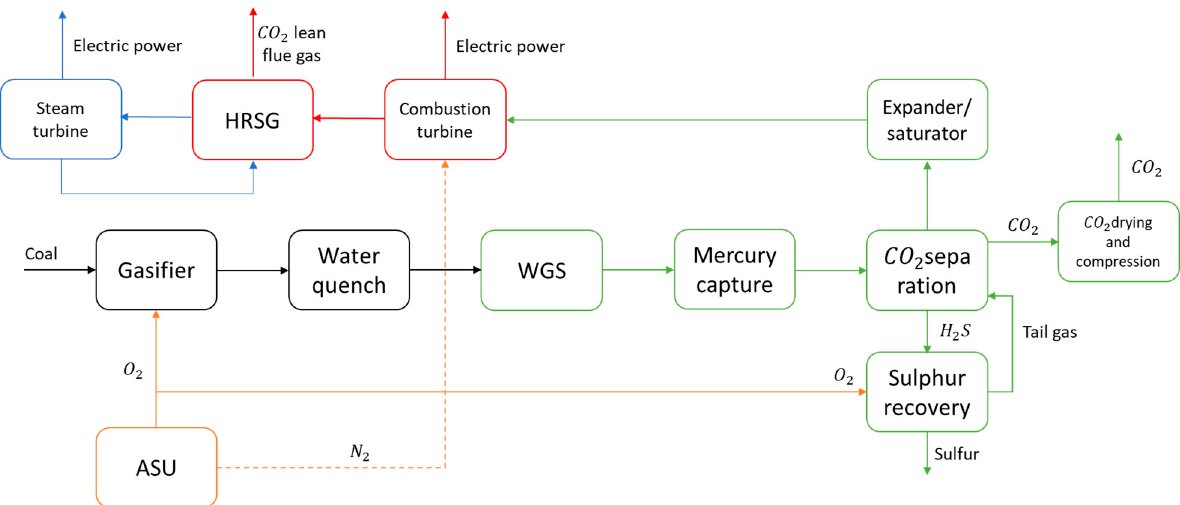
Figure 4. IGCC block flow diagram with CO 2 capture. Table 2. Summary of the results of new IGCC power plants with and without a pre-combustion capture system